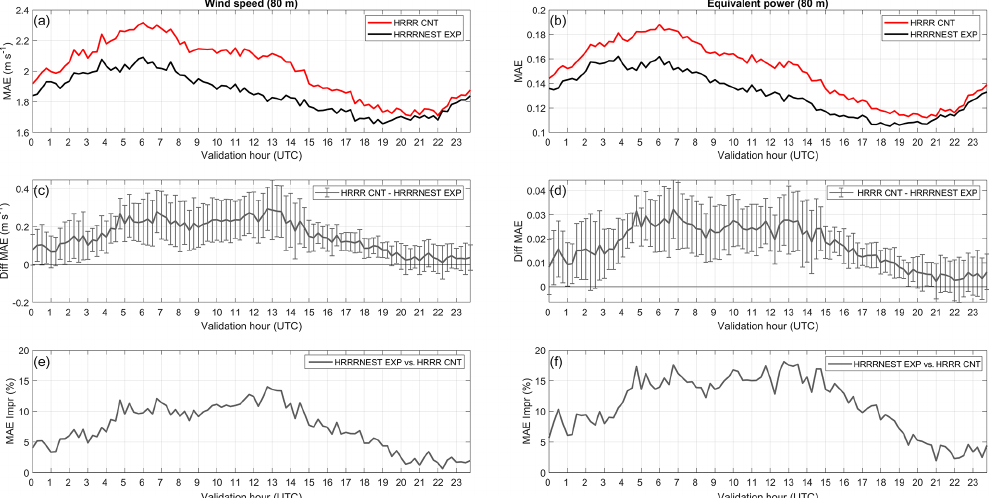
Figure 8. As in Fig. 6 but for HRRRNEST EXP (in black) vs. HRRR CNT (in red) runs, showing the combined impact on 80m wind speed MAE of the experimental physics and finer model horizontal grid